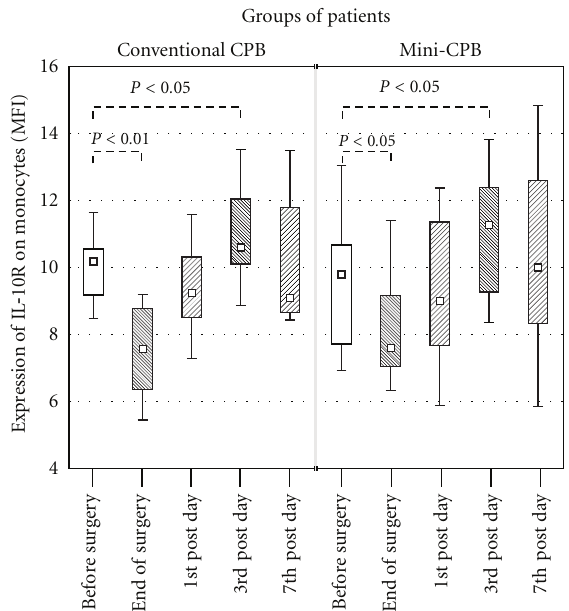
Figure 5: Expression of IL-10R on monocytes in peripheral blood samples of conventional CPB or mini-CPB group as a result of flow cytometry data analysis. The expression of IL-10R did not signifi- cantly di ff er between both groups of patients. Squares display med- ian, boxes are quartiles, and whiskers display the range of nonoutlier